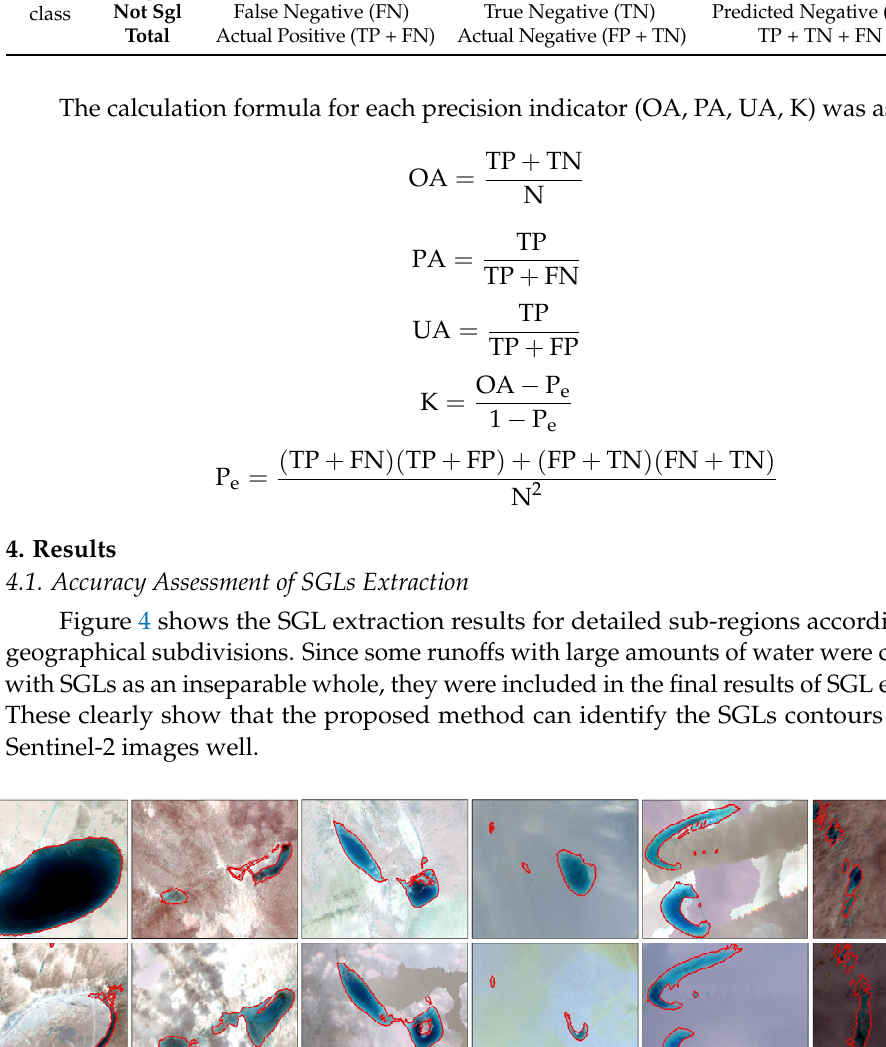
Figure 5. Temporal and spatial distribution of SGLs in Greenland during the melt seasons from 2016 to 2018. The various types of lakes are labeled as “0–0.5”, “0.5–1”, “1–5”, “5–10”, and “10–20” which was used to indicate the percentage of the number of each type of SGLs in each year).